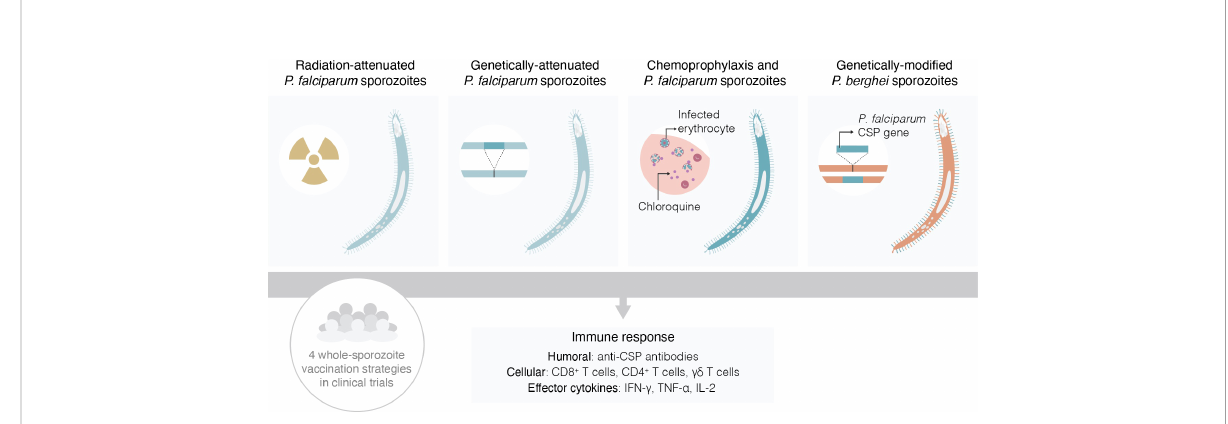
FIGURE 1 Schematic representation of the four types of whole-sporozoite vaccines against malaria assessed in clinical